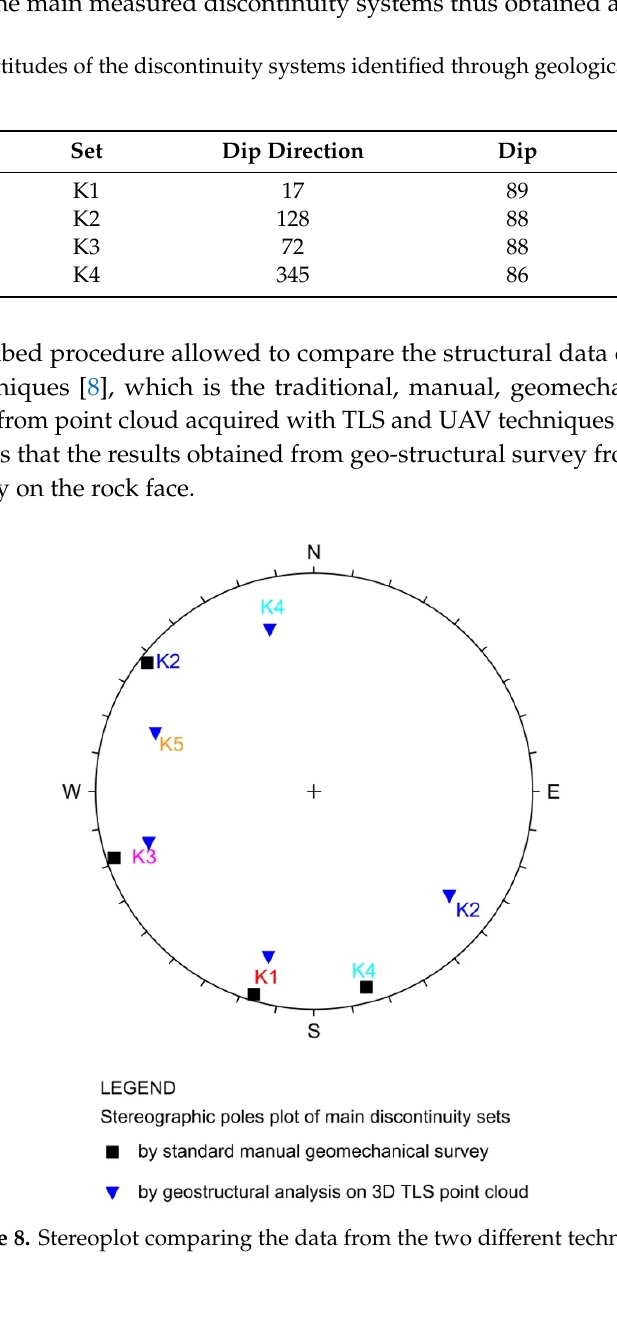
Table 2. Average attitudes of the discontinuity systems identified through geological measurements on the rock mass.